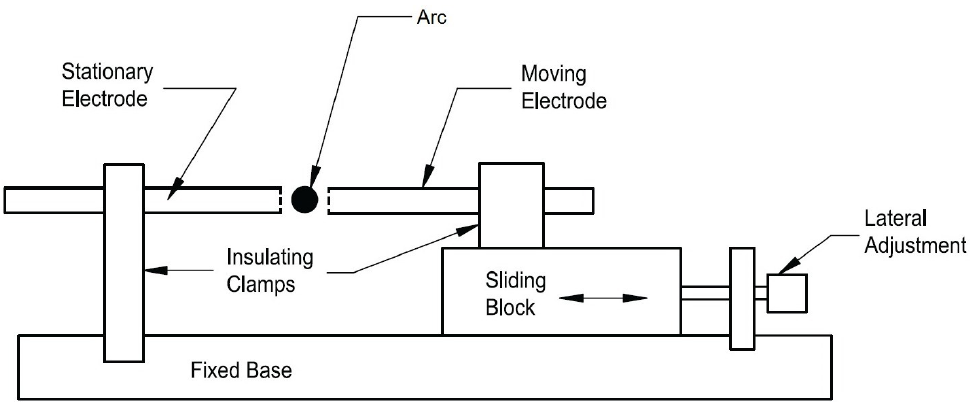
Figure 2. UL1699B AF generator mechanism